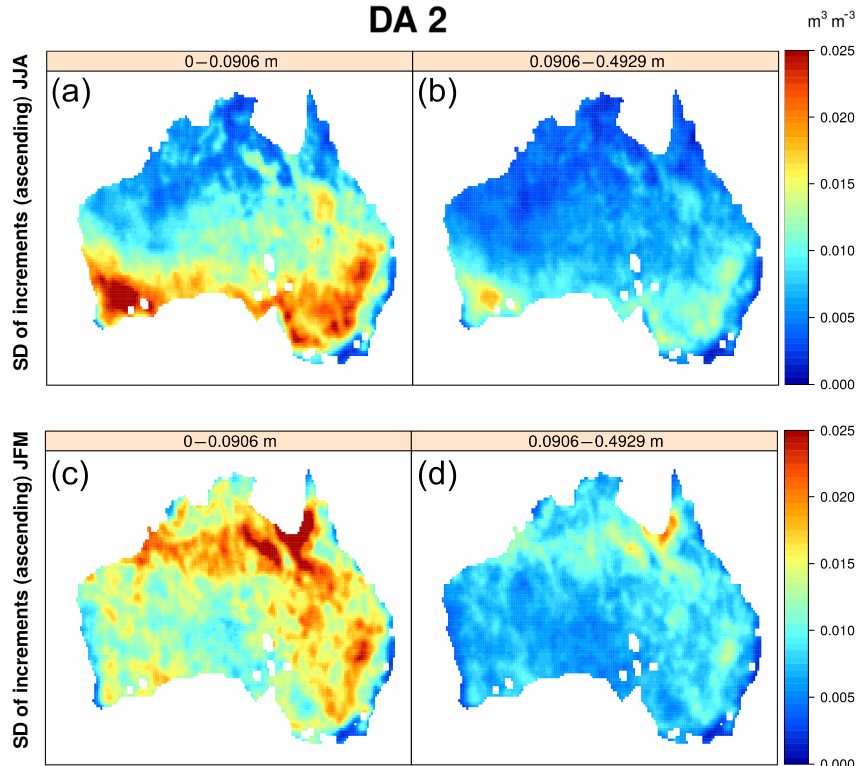
Figure 8. Increment standard deviation for ascending orbits for June–August (a, b) and January–March (c, d) for experiment DA 2. For the austral winter, increments are strongest for the south of Australia, especially the agricultural areas. During austral summer, the increments are strongest for the northern